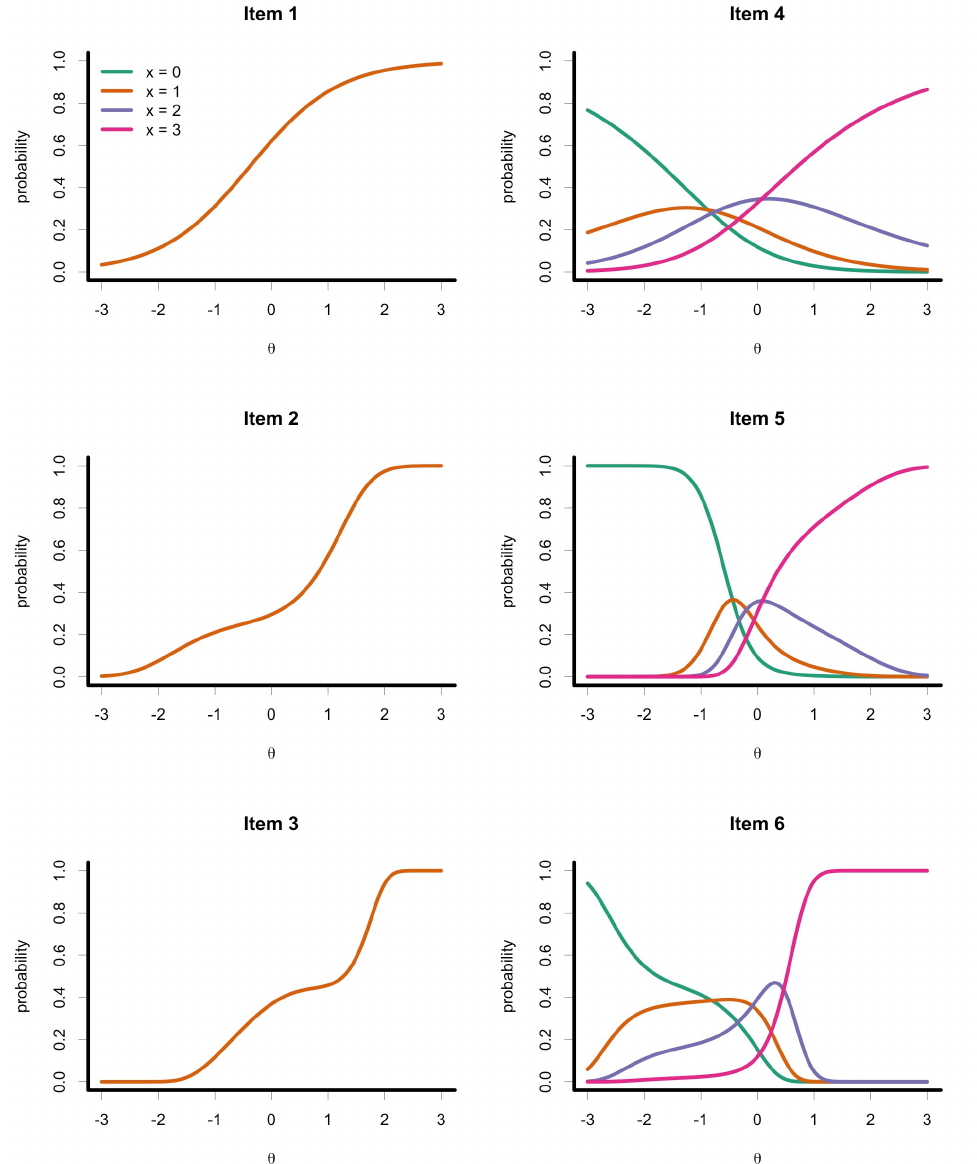
Figure 1. Item response functions for six example FMP items. Items 1, 2, and 3 are dichotomous, and items 4, 5, and 6 have four response categories. Items 1 and 4 have k i = 0, items 2 and 5 have k i = 1, and items 3 and 6 have k i =